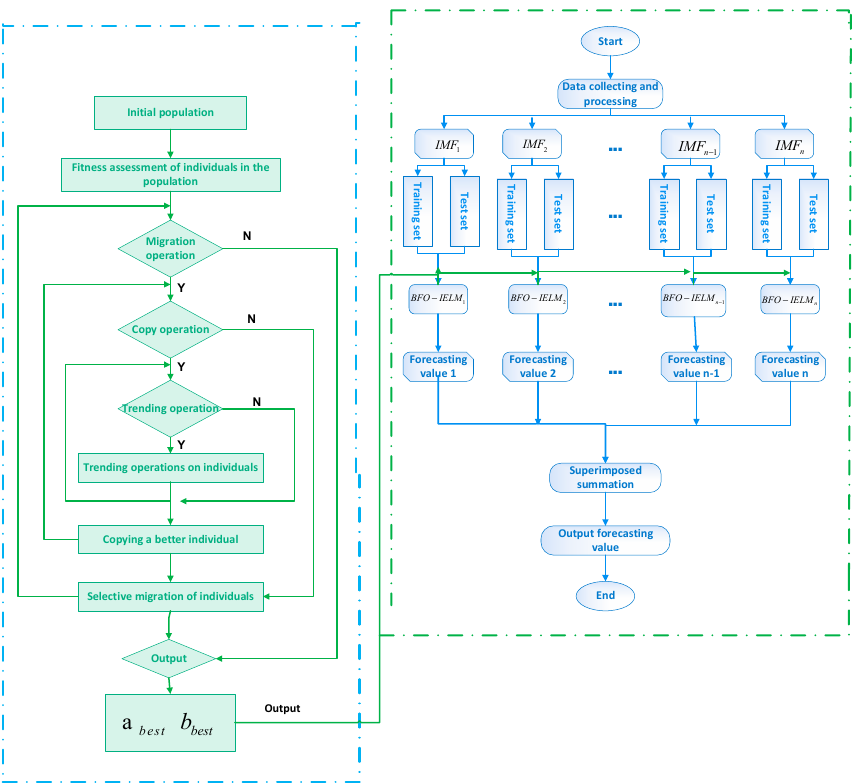
Figure 3. EMD-BFO-IELM algorithm flow chart.